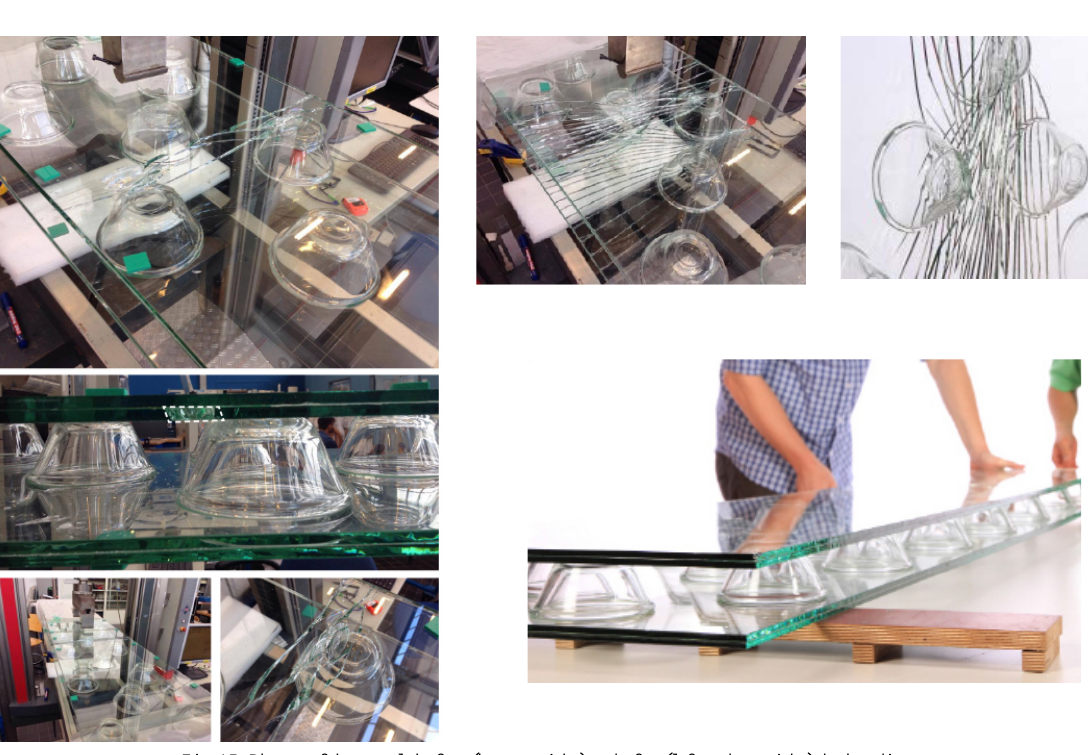
Fig. 15: Photos of the panels before (bottom right) and after (left and top right) the bending